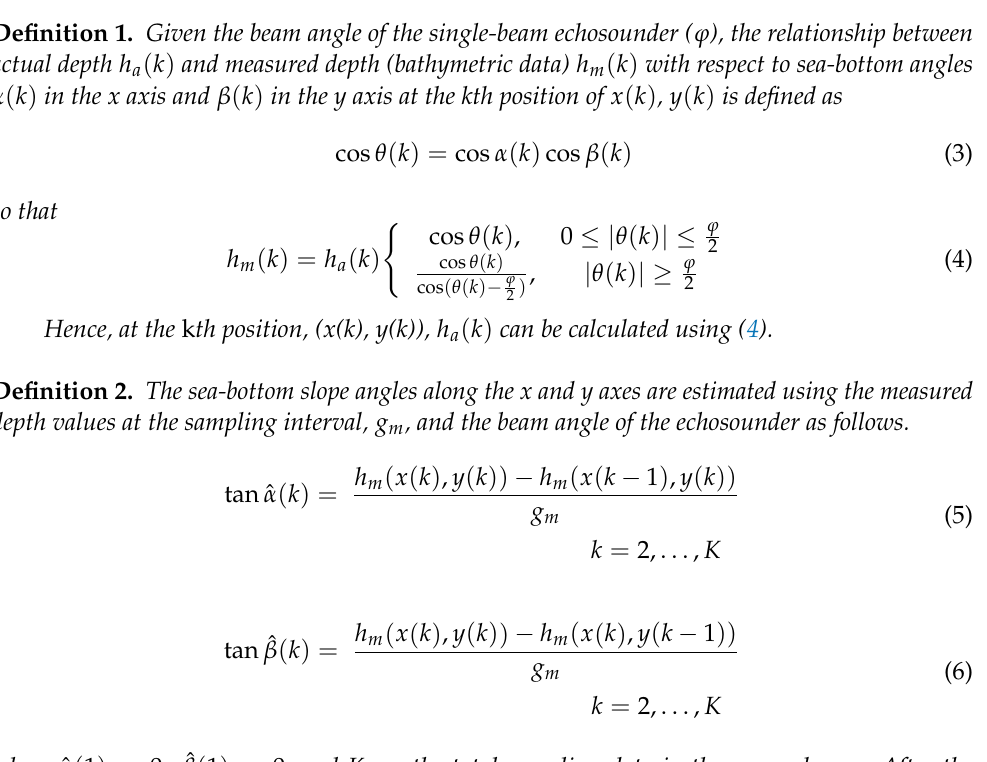
Figure 2. ( a ) Sea-bottom coverage for a flat seafloor. In this situation, h m = h . ( b ) Theta angle ( θ ) related to the seafloor slope is inside the insonified (conical) area for inclined seafloor. In this situation, h m (cid:54) = h . ( c ) Theta angle related to the seafloor slope is outside the insonified (conical) area for an inclined seafloor. In this situation, h m (cid:54) = h